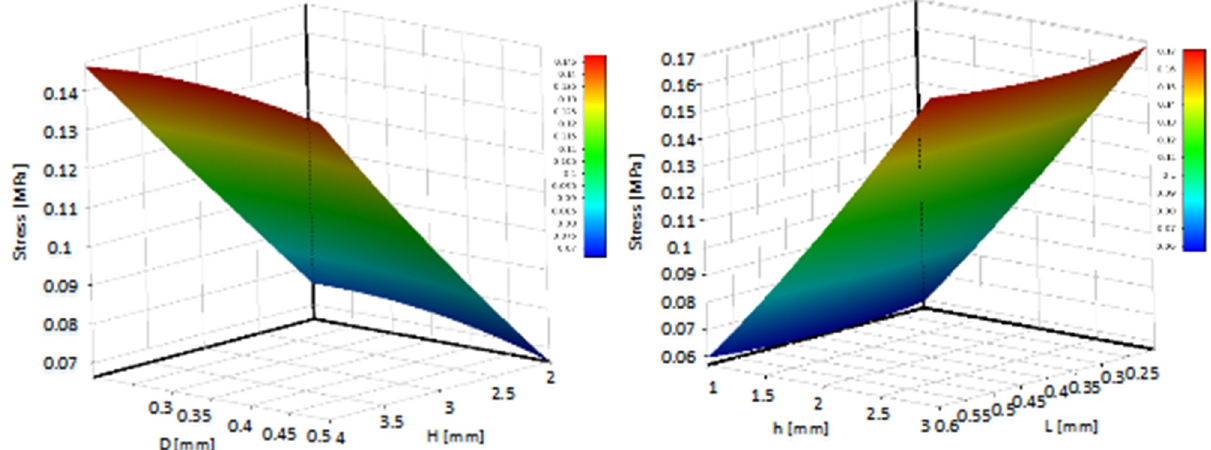
Fig. 6. The relationship between parameters (H, h, R, L) and maximum stress on the cantilever beam.